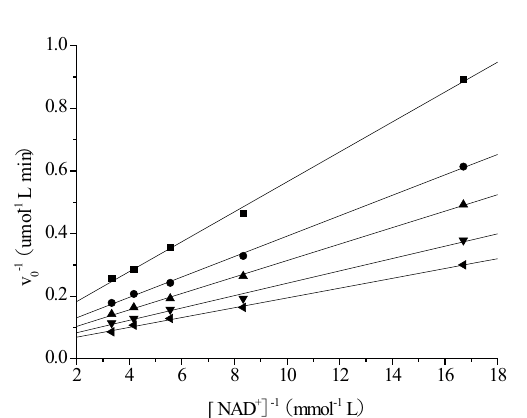
Figure 4. Secondary replot of the intercepts ( ● ) and slopes ( ○ ) of the fitted lines in Fig. 3 vs. the corresponding inverse concentrations of C H OH. 2 5